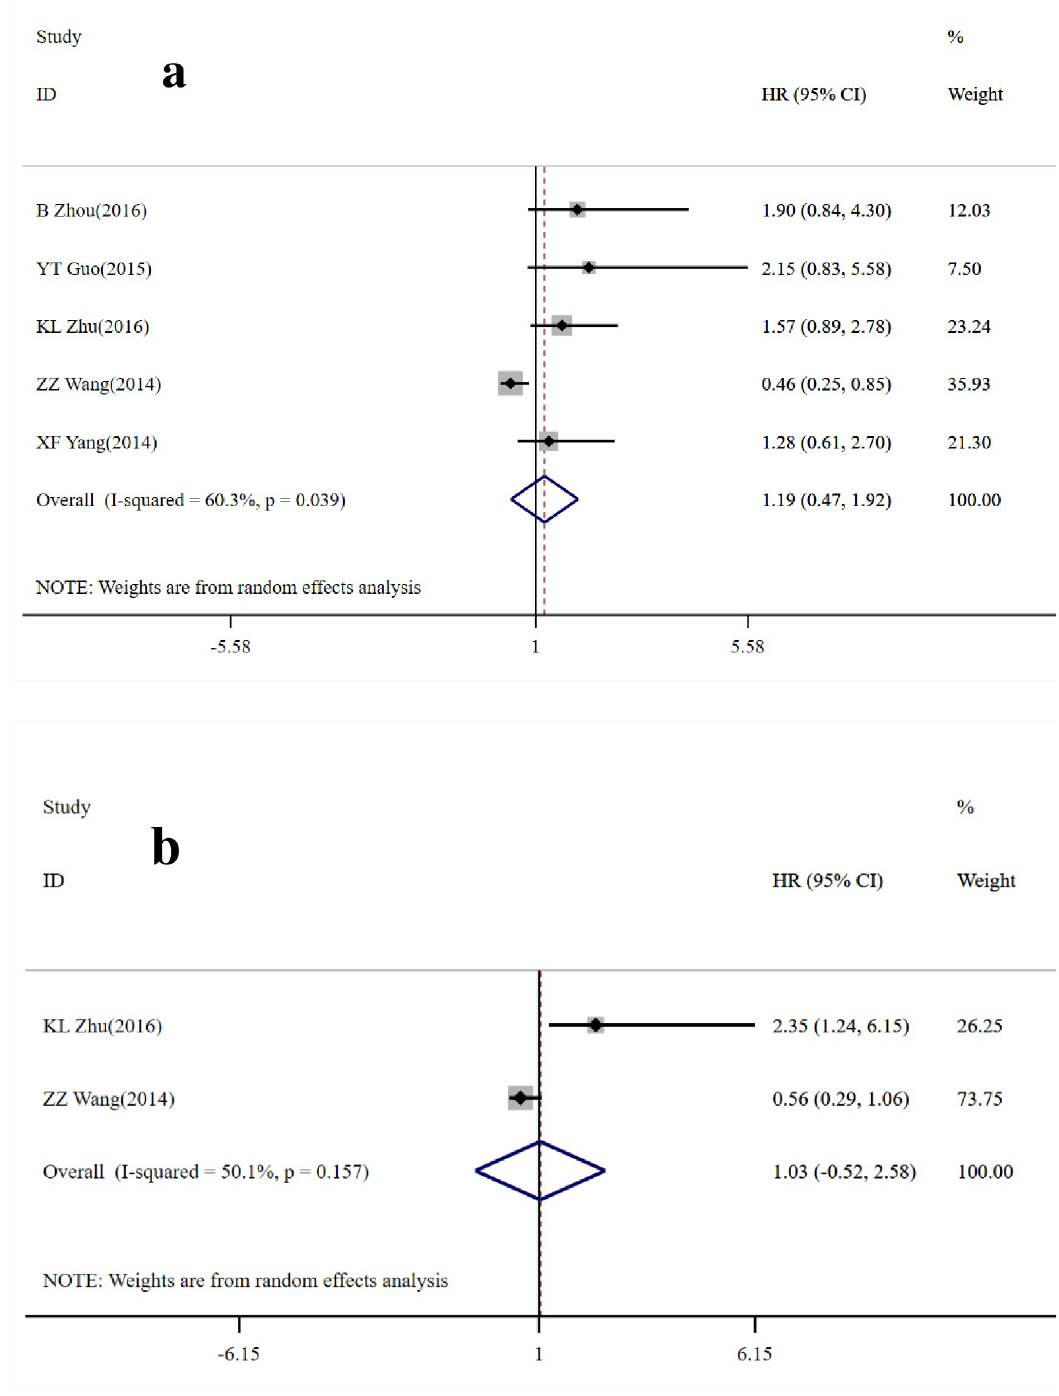
Fig 4. Forest map of the relationship between GOLPH3 expression and overall survival (OS). a: univariate analysis; b: multivariate analysis. The horizontal line represents the range in which the truth value of the study exists. The dots on the horizontal line represent the effect size of a single study, and the size of the dots represents the weight. Diamonds represent the result of the merger.